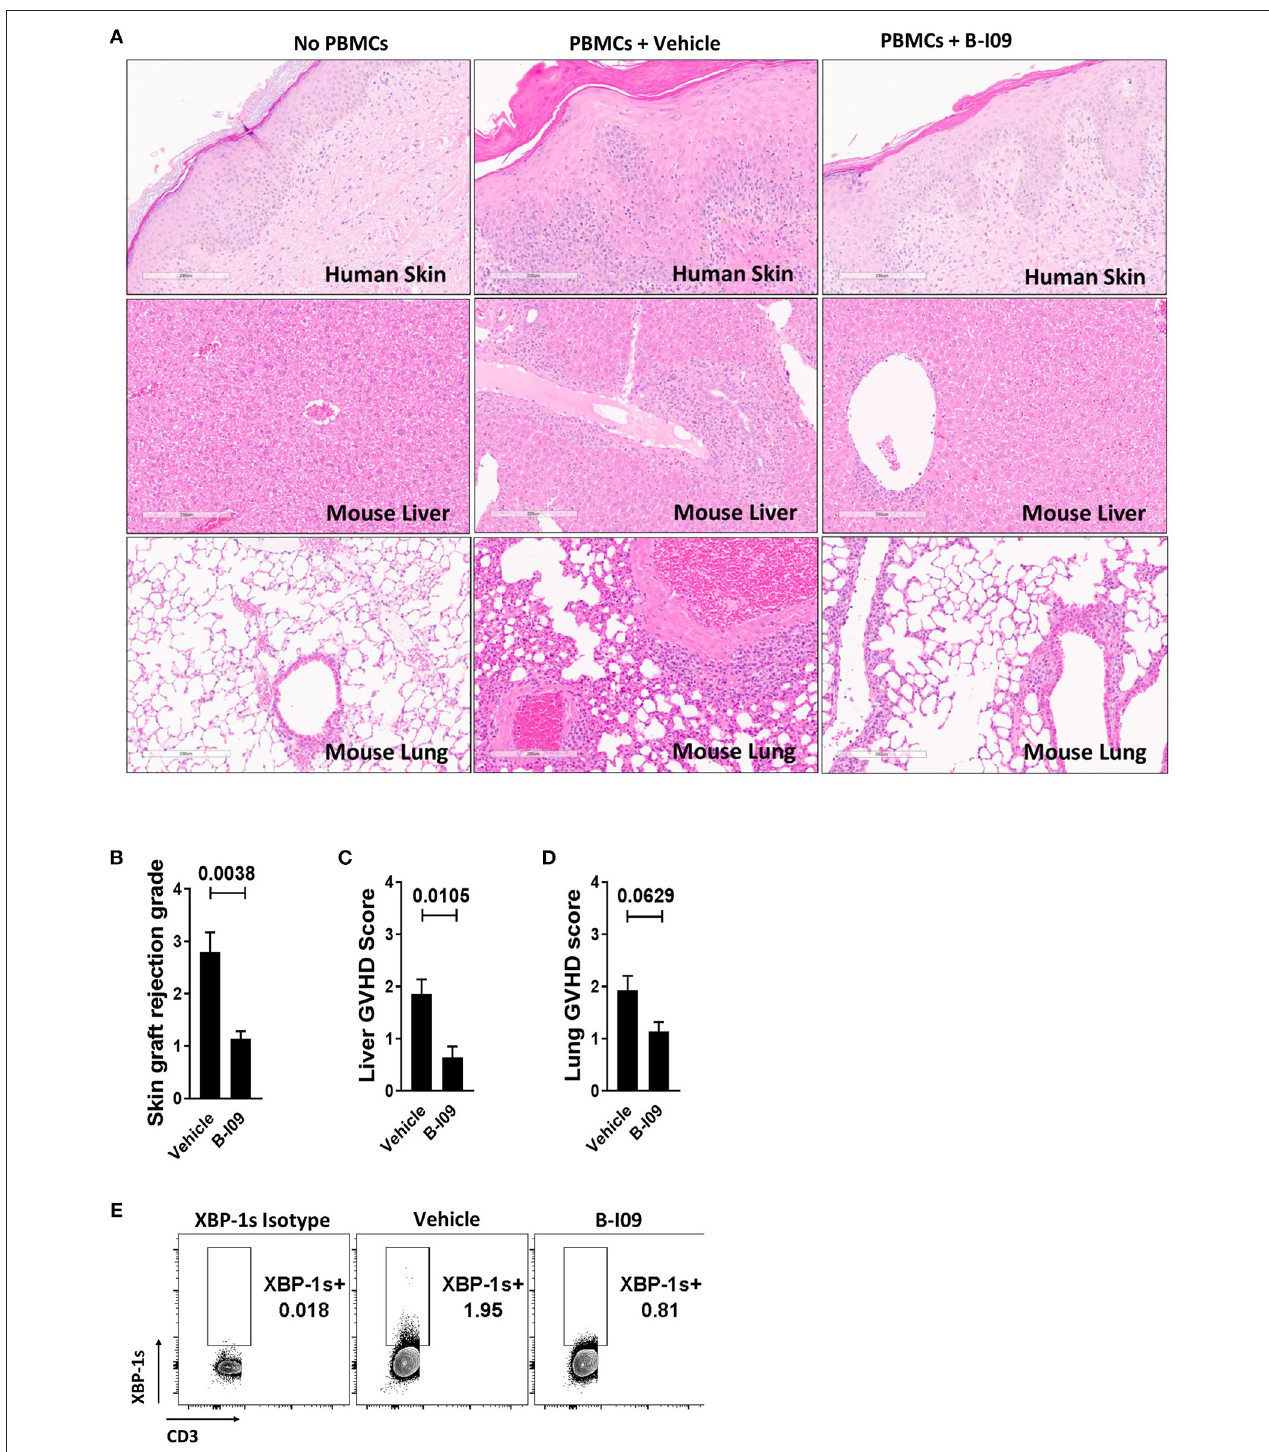
FIGURE 6 | XBP-1s blockade reduces human skin graft rejection and xenogeneic GVHD. NSG mice received a 1 cm 2 split thickness human skin graft. After 30 days of rest to permit engraftment, 5 × 10 6 human PBMCs (allogeneic to the skin) were injected into the mice. Unique pairs of donor skin and allogeneic PBMCs were used for each set of experiments. B-I09 30 mg/kg or vehicle was given by i.p. injection 5 days a week for 3 weeks. Mice were humanely euthanized and the skin graft, spleen, lung, and liver were harvested from the recipient on day + 21 from time of PBMC injection. (A) Representative H&E sections compare skin graft rejection and xenogeneic GVHD in the liver and lung among no PBMC controls, mice that received PBMCs plus vehicle, and mice that received PBMCs plus B-I09 (100X). (B–D) Bar graphs show skin graft rejection and xenogeneic GVHD scores (blinded assessment) at day + 21. (E) Representative contour plots show the amount of detectable XBP-1s in CD3 negative cells residing in the murine spleen at day + 21. Pooled data from two independent experiments, up to 7 mice per group, Mann–Whitney test.